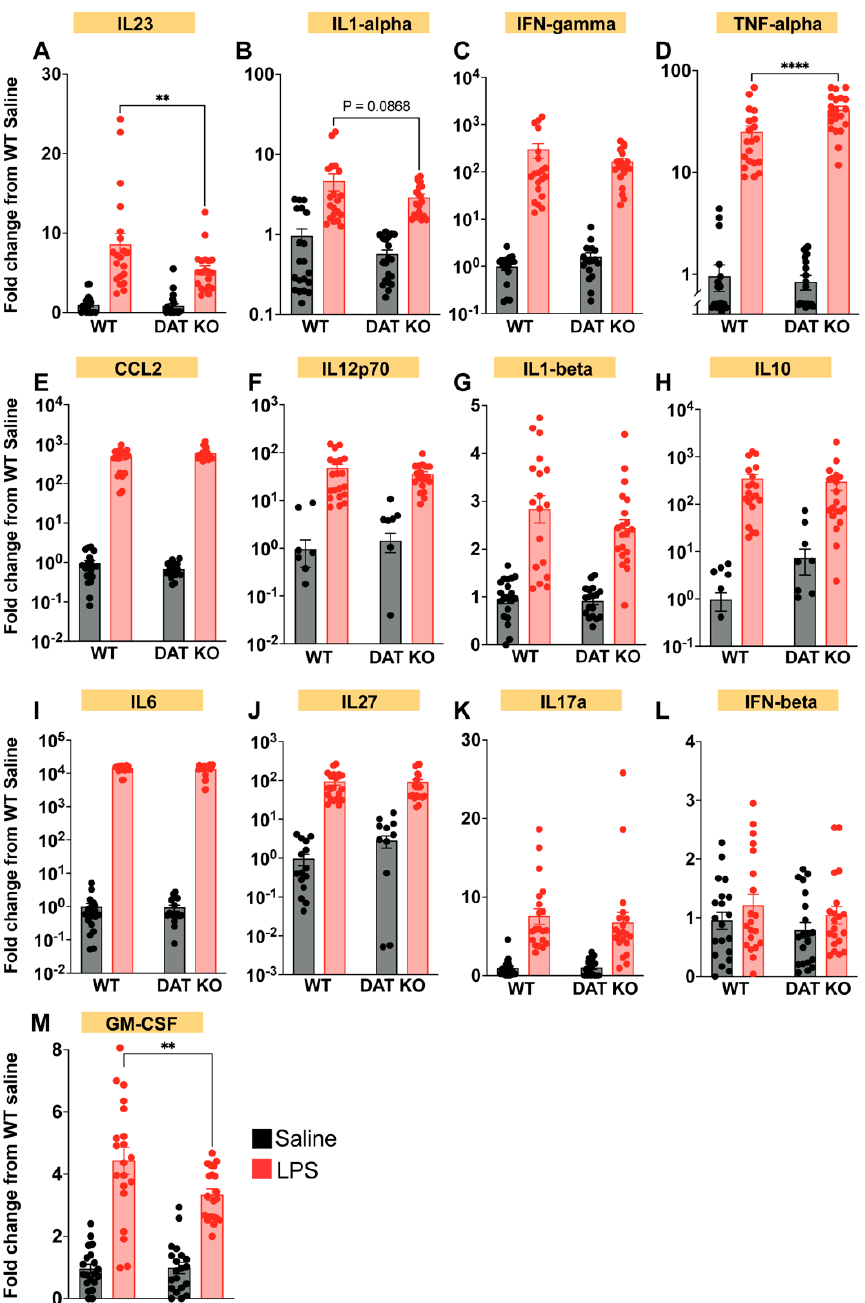
Figure 9. Serum cytokine quantification indicates DAT − / − mice exhibit altered immune response to systemic endotoxemia compared to WT controls. Both DAT − / − and WT animals show serum cytokine changes in response to systemic endotoxemia. However, following immune stimulation, DAT − / − animals show decreased serum IL23 ( A ) and GM-CSF ( M ), and elevated TNF-alpha ( D ), while baseline (saline) cytokine responses are not different between the two groups. No changes were detected in IL1-alpha, IFN-gamma, CCL2, IL12p70, IL1-beta, IL10, IL6, IL27, IL17a, IFN-beta ( B , C , E – L ) These findings are in line with observed changes in some but not all peripheral immune cell populations and functions. (Two-way ANOVA with Sidak’s correction for multiple